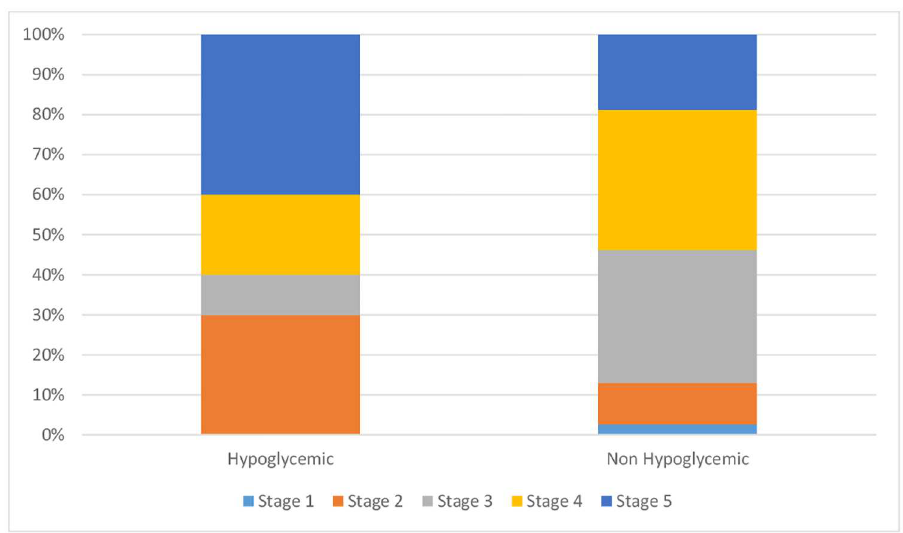
Fig 3. Preadmission CKD stage distribution comparison between groups.